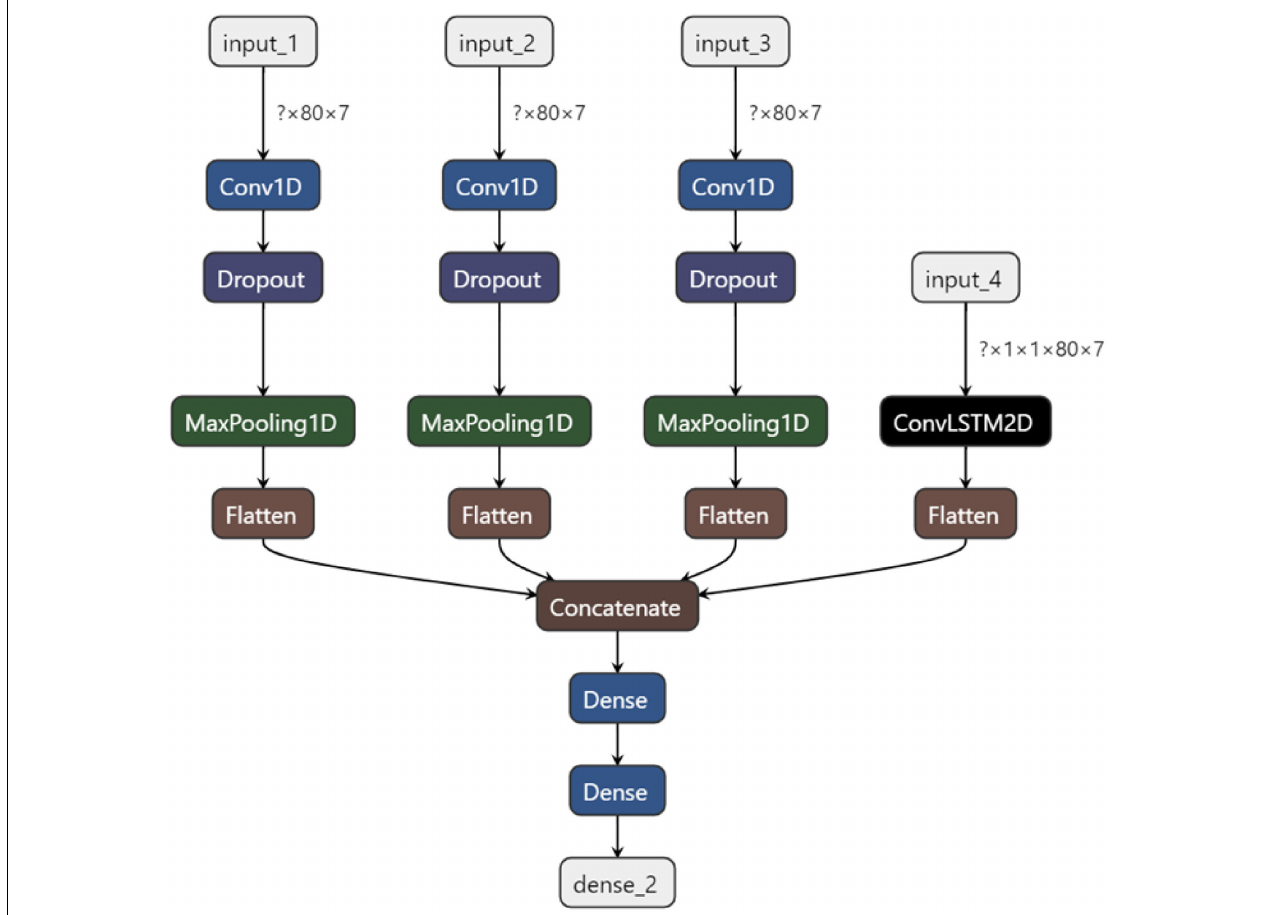
FIGURE 7 | Model structure.